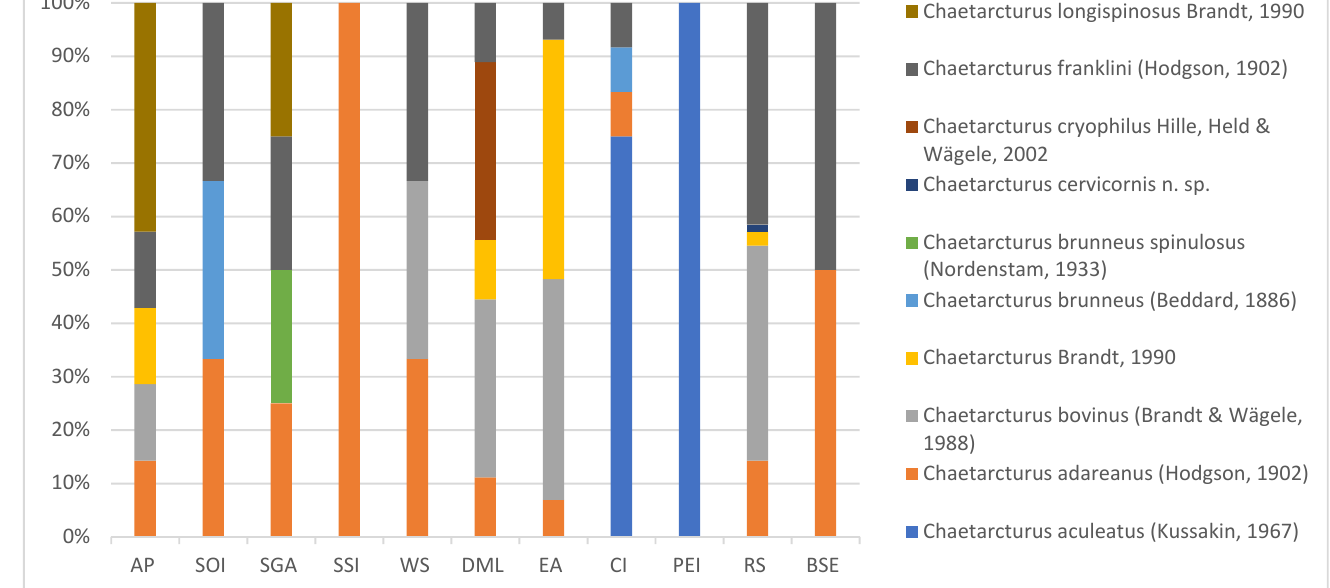
Figure 3. Percentage of MNA individuals of Chaetarcturus Brandt, 1990 species related in each area: areas in this study are AP (Antarctic Peninsula), SOI (South Orkney Islands), SGA (South Georgia Area), SSI (South Sandwich Islands), WS (Weddell Sea), DML (Dron-ning Maud Land), EA (East Antarctica), CI (Crozet Islands), PEI (Prince Edward Is-lands), RS (Ross Sea), BSE (Bellingshausen Sea East).